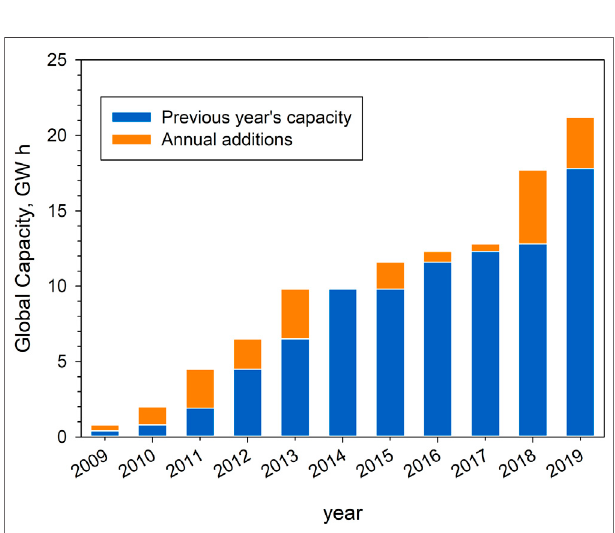
FIGURE 2 | CSP thermal energy storage global capacity and annual addition from 2009 to 2019 (adapted from REN21 (2020)).